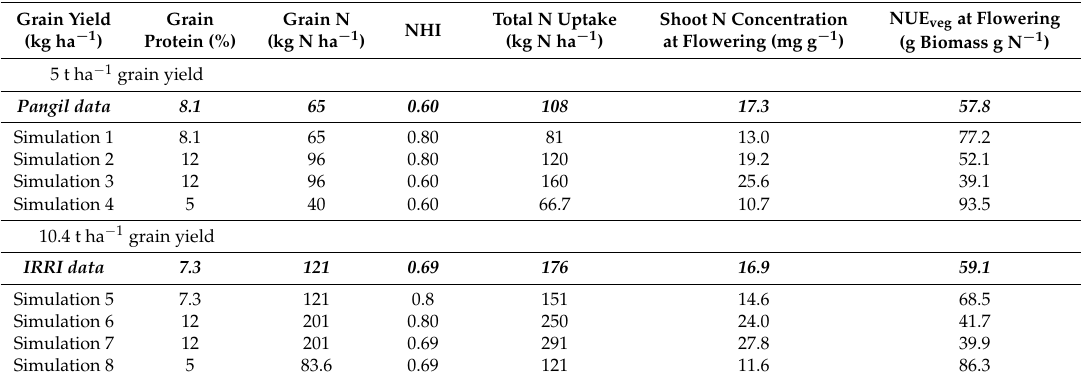
Table 3. Simulating possible changes in nitrogen uptake and NUE veg in dependence on target levels of grain protein concentrations or NHI. At constant target protein levels breeding for increased NHI would lower the minimum plant N content required to fill grains and that could improve the NUE veg at